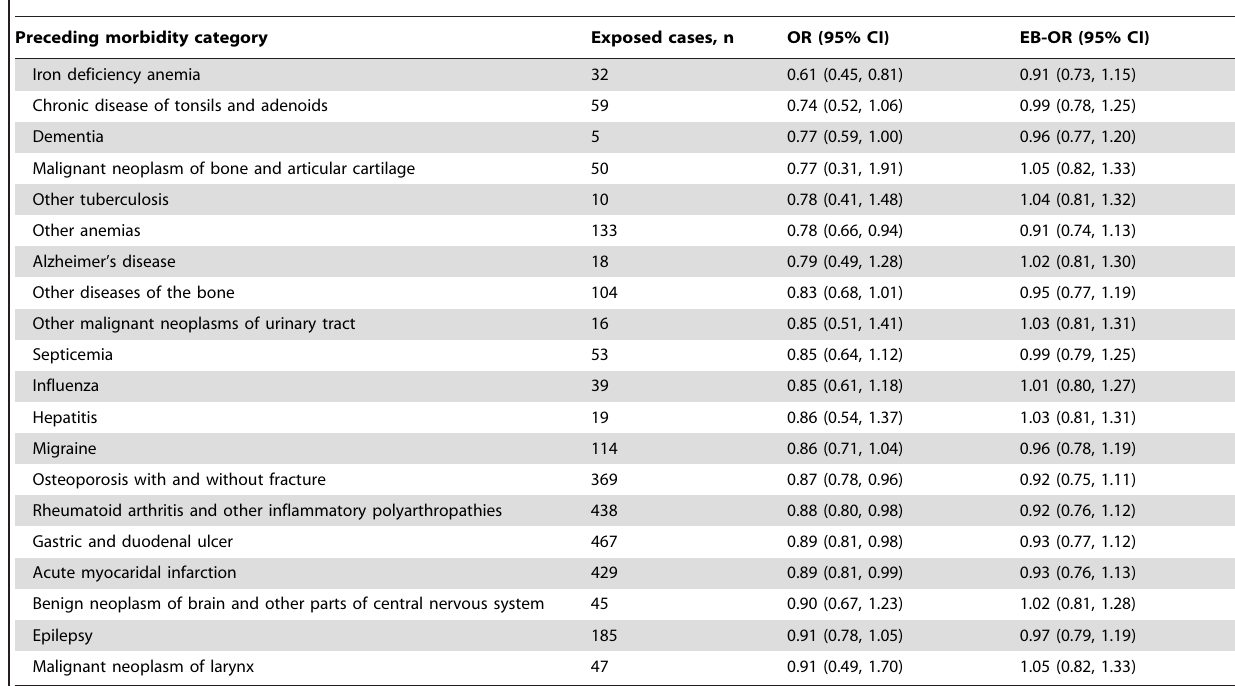
Table 5. The 20 preceding morbidity categories most strongly associated with decreased breast cancer incidence.